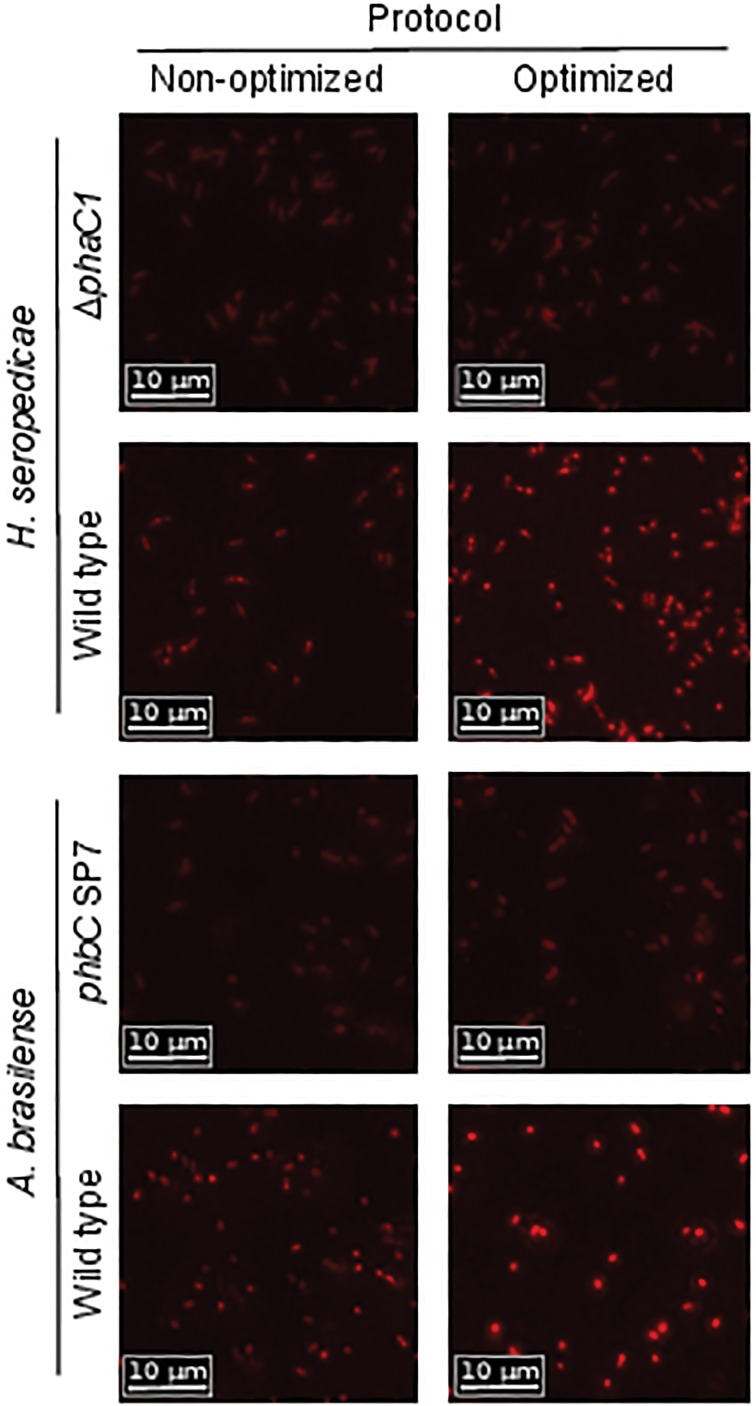
Intracellular PHB detection by fluorescence microscopy using the
non-optimized and optimized protocols. H. seropedicae strain
SmR1, a mutant strain of H. seropedicae,
ΔphaC1, A. brasilense strain FP2, and a
mutant strain of A. brasilense, phbC SP7 were
grown to OD600 of 1.4 using 5 mM NH4Cl in growth medium.
Fluorescence microscopy analysis was performed using the procedure described in
the Material and Methods.